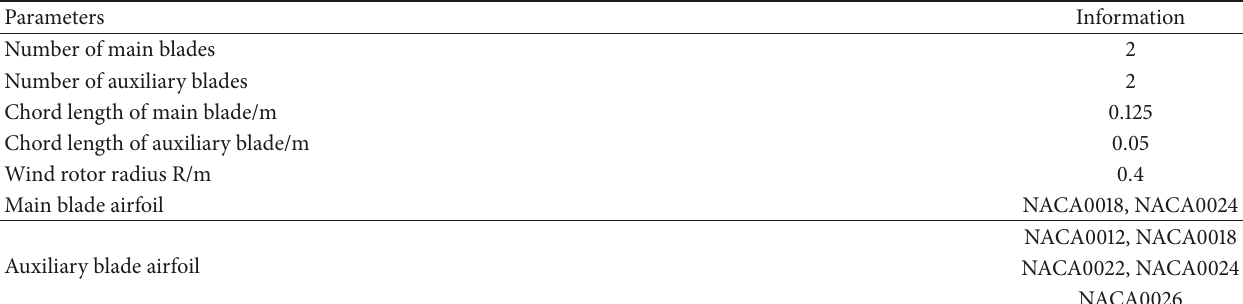
Table 1: Parameters of rotor model.